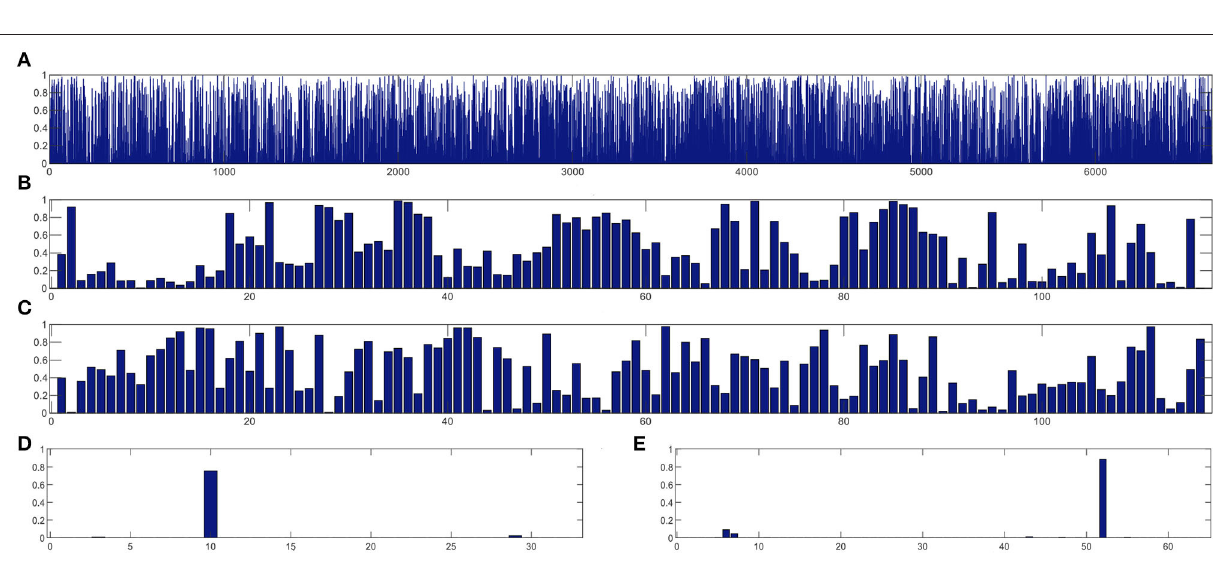
FIGURE 8 | The discriminative power of features between AD and NC groups learned by (A) baseline, (B) CC, (C) M 2 TFS, (D) CNN, and (E)